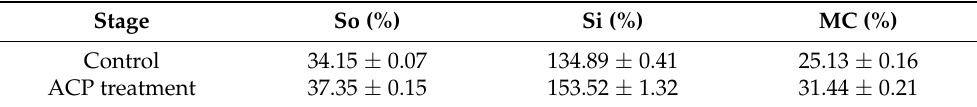
Table 1. Solubility, swelling index, and moisture content of soy protein film. ACP treatment is soy protein film treated for 3 min, at 30 kV. The control is untreated soy protein film. Stage So (%) Si (%) Control